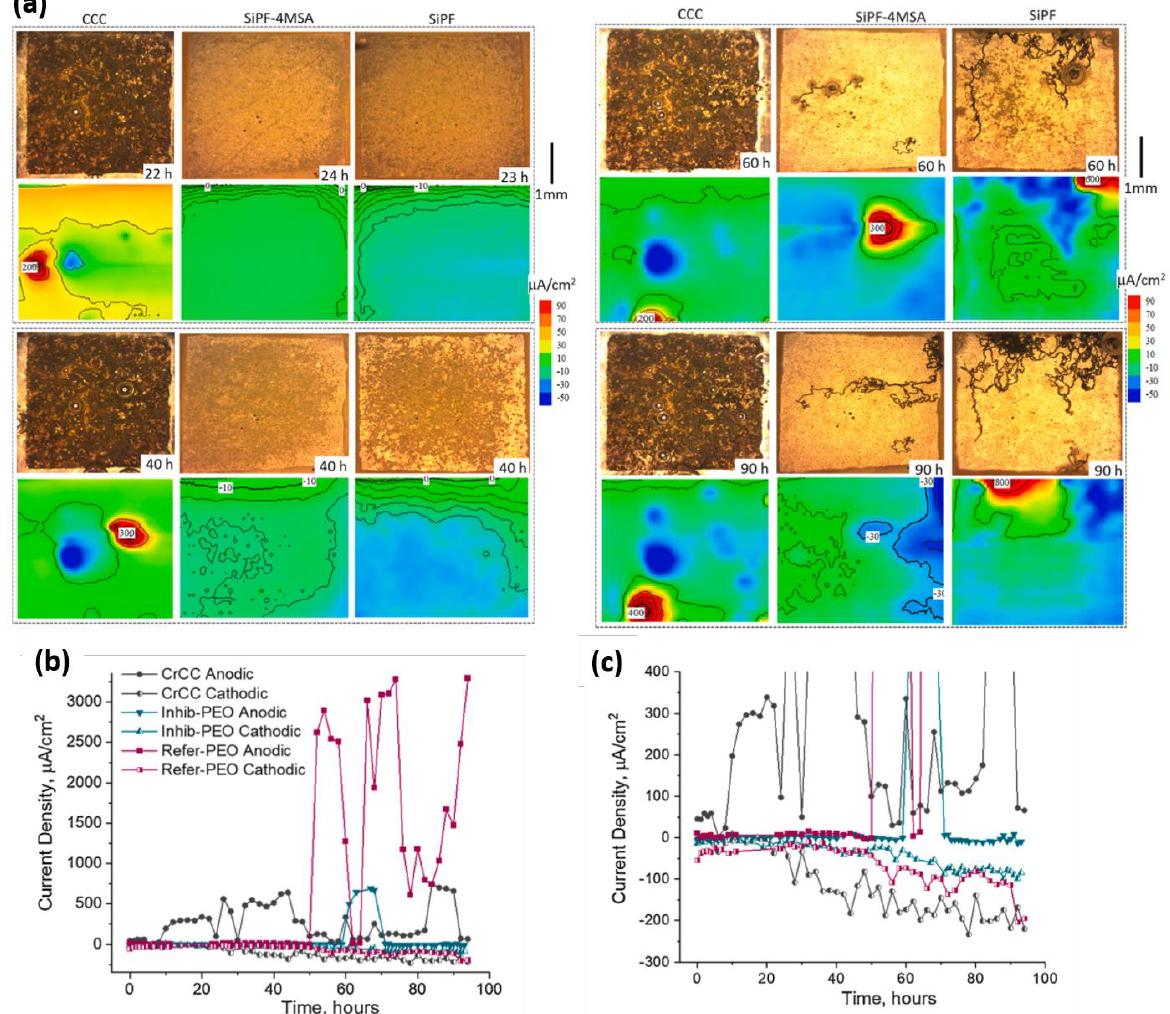
Figure 25. ( a ) Optical micropgraphs and SVET current density maps of reference CCC and PEO coatings with and without 4MSA inhibitor, acquired during immersion in 0.05 M NaCl. The immersion time is specified in each section of this Figure. ( b , c ) Evolution of the peak current density, anodic and cathodic, for three types of tested samples during 96 h of immersion in 0.05 M NaCl. “SiPF” refers to the reference PEO sample. Adapted [264] with permission from Elsevier.